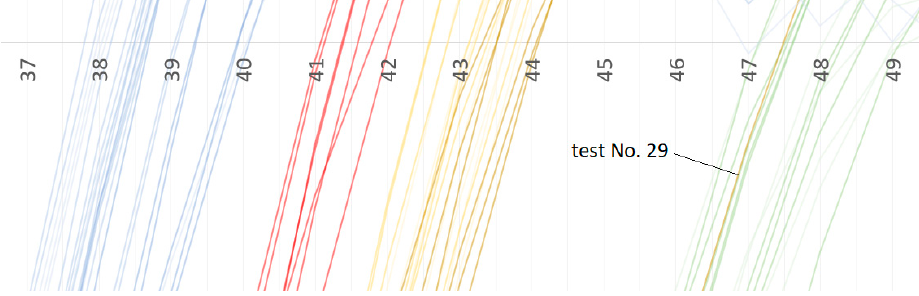
Figure 11. The curve of the test No. 29—out of phase, zoomed in.